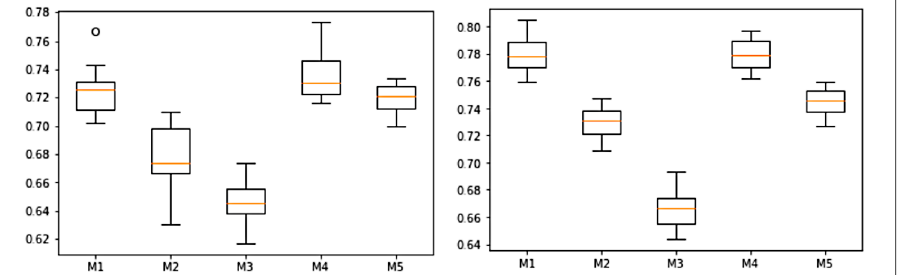
Figure 1 Boxplot of predictive performance for the five models (M1)–(M5) for ideological leaning (left) and party preference (right)